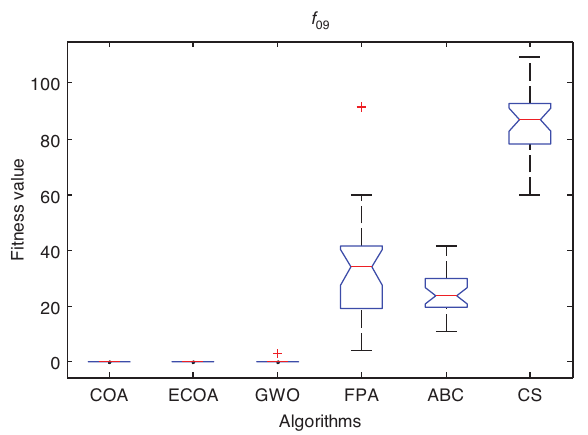
Figure 18: D = 30, ANOVA Test of Global Minimum for f